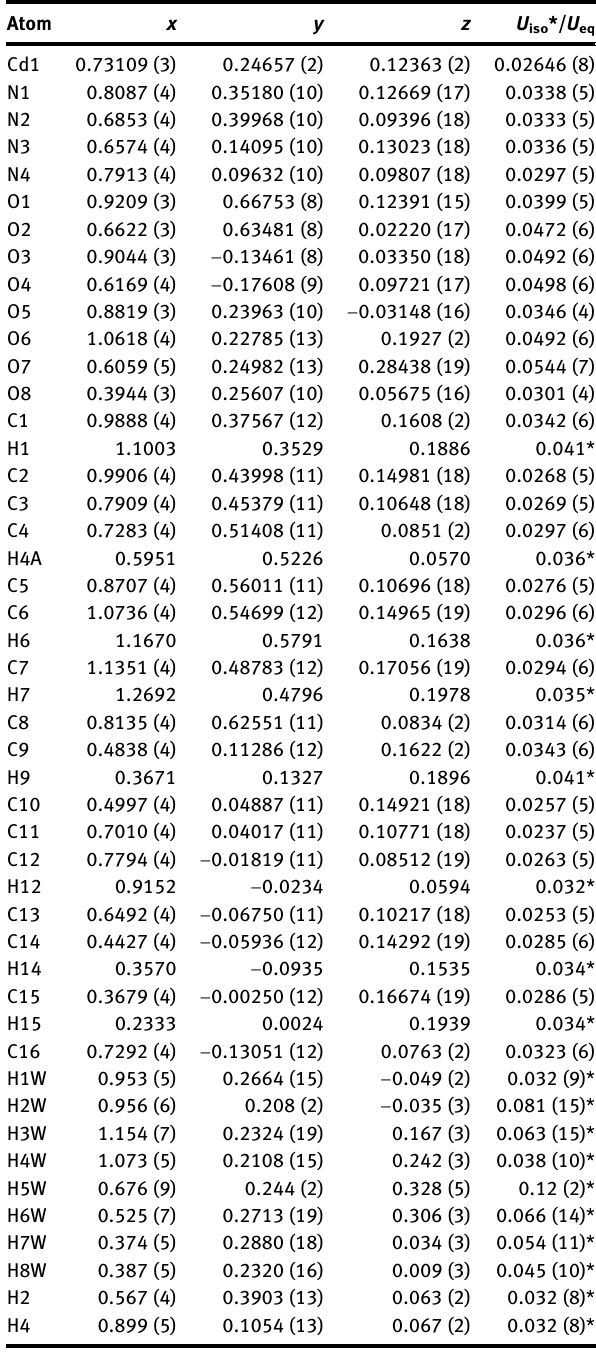
as bridging ligands [7 – 14]. Recently, our group also reported fi ve coordination polymer with the 2-methyl-1 H -